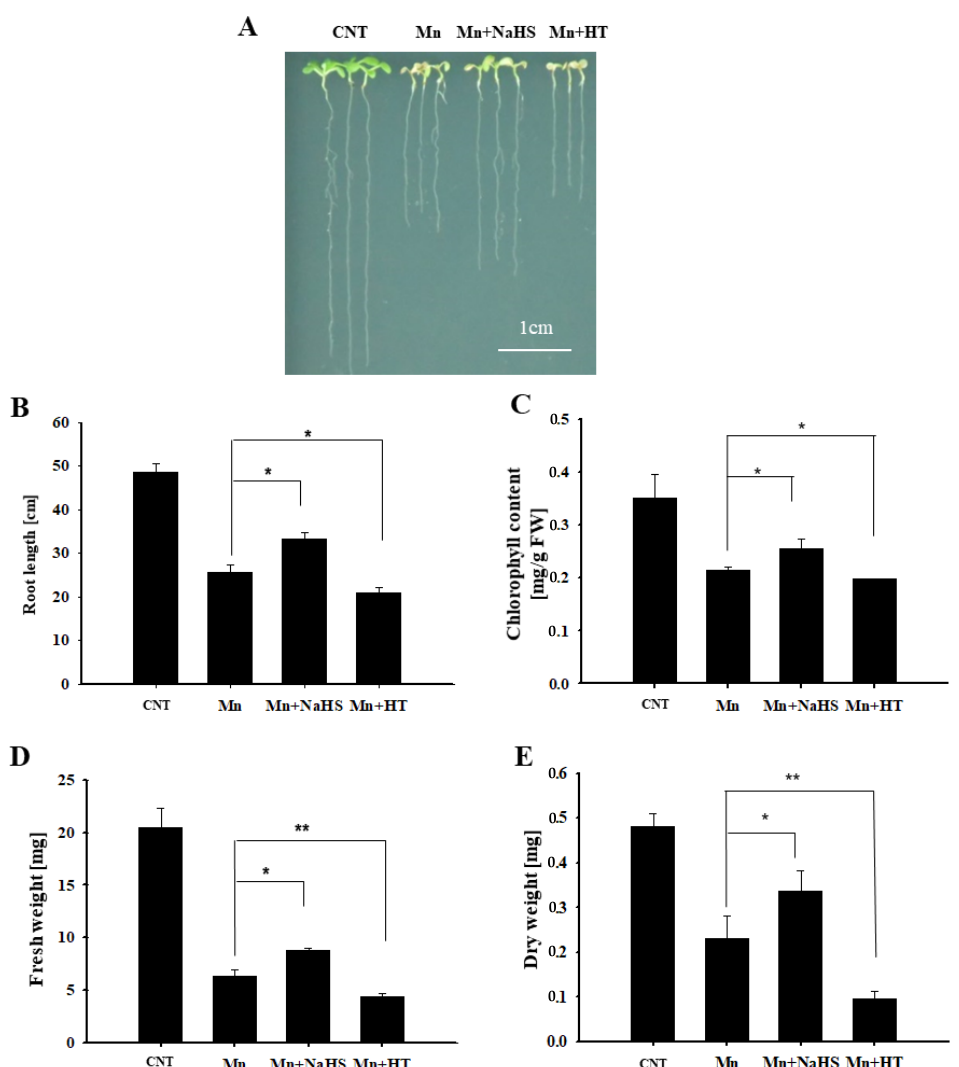
Figure 2. Effects of NaHS and HT on the growth of wild-type Arabidopsis seedlings under Mn stress. Effects of NaHS and HT on the phenotype ( A ), root length ( B ), chlorophyll content ( C ), fresh weight ( D ), and dry weight ( E ) of wild-type Arabidopsis under Mn stress. Three independent experimental replications were conducted. Values are the means ± SE of three independent experiments (* p < 0.05, ** p < 0.01). Scale bar = 1cm.